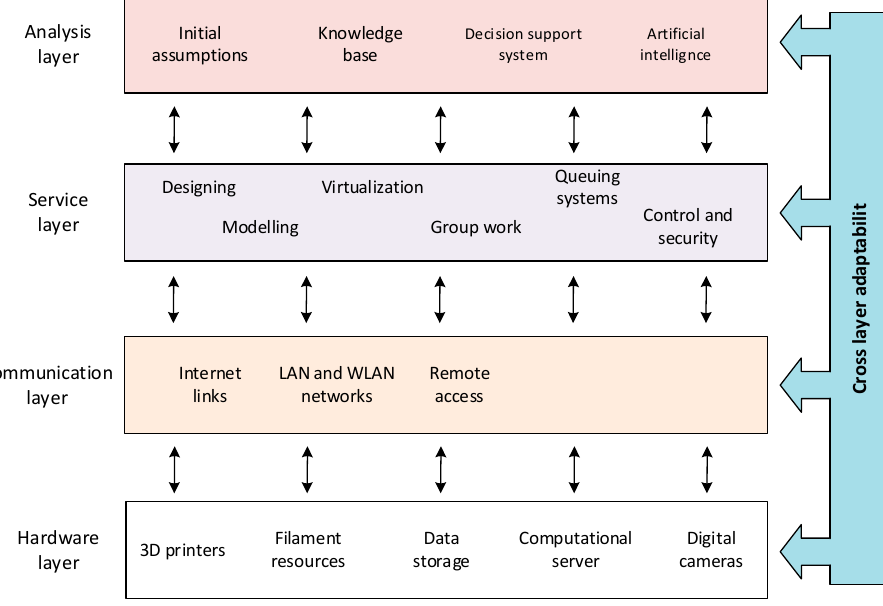
Figure 2. Proposed cross-layer framework.